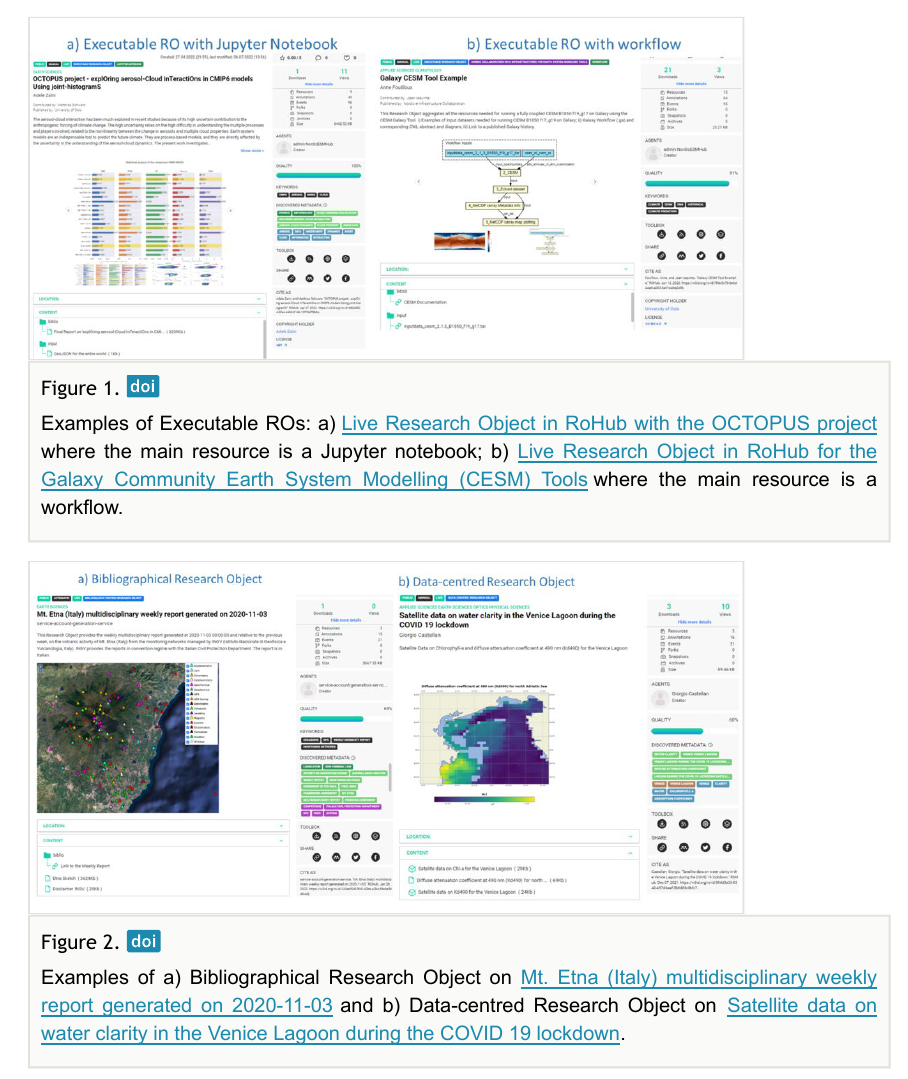
Fig. 2: the overall overview of any types of Research Object is always the same with mandatory metadata information such as the title, description, authors & collaborators, sketch (featured plots/images), the content of the RO (with different structures depending on the type of ROs). Additional information is displayed on the right panel such as number of downloads, additional discovered metadata (automatically discovered from the Reliance text enrichment service), free keywords (added by end- users) and citation. The ' toolbox ' and ' share ' sections allows end-users to download, snapshot and archive the RO and/or share it.